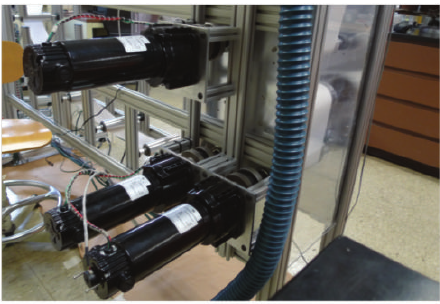
Figure 4: Two DC motors employed to apply unwind and rewind torques to the chucks. The third motor drives the traction roller.